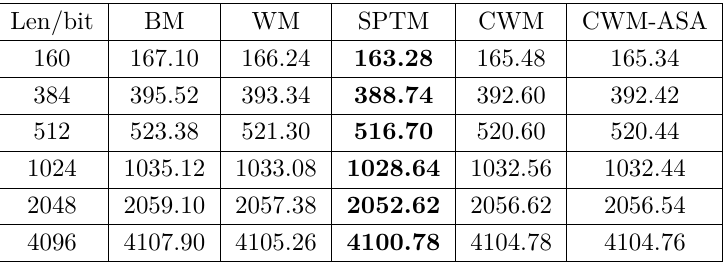
Table 4: Average test results of effective types for